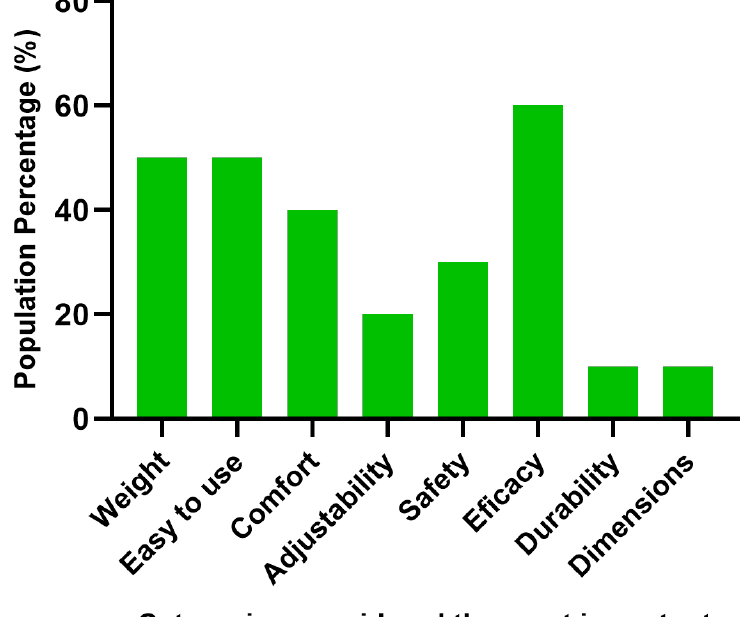
Figure 6. Categories considered by the users as the most important ones regarding the questions completed in the satisfaction